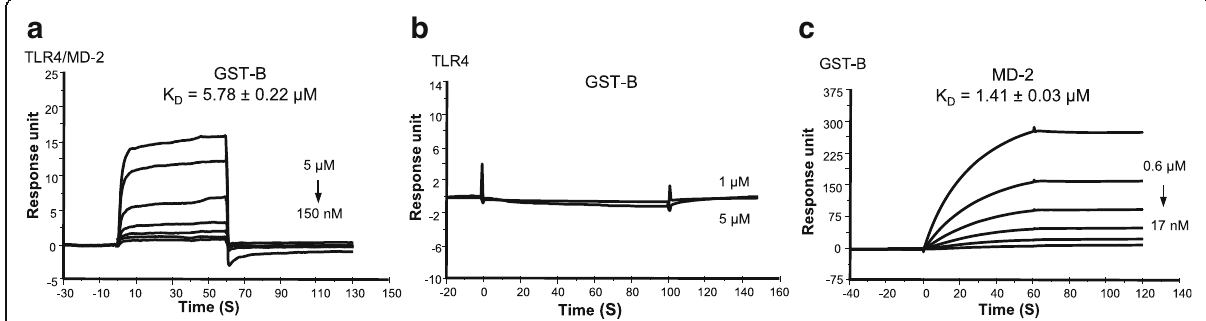
Fig. 4 SPR analyses of GST-B-box binding to TLR4/MD-2, TLR4 and MD-2. a TLR4/MD-2 complex was coated on the CM5 chip, GST-B-box binds to TLR4/MD-2 complex with a K D of 5.78 ± 0.22 μ M. b TLR4 was coated on the chip, GST-B-box has no significant binding to TLR4. c GST-B-box was coated on the CM5 chips, MD-2 was used as analyte, MD-2 showed better binding affinity to GST-B-box (K D of 1.41 ± 0.03 μ M) relative to GST-A- box (K D = 3.25 ± 0.17 μ M). GST tag was used as negative control. Data are representative of three